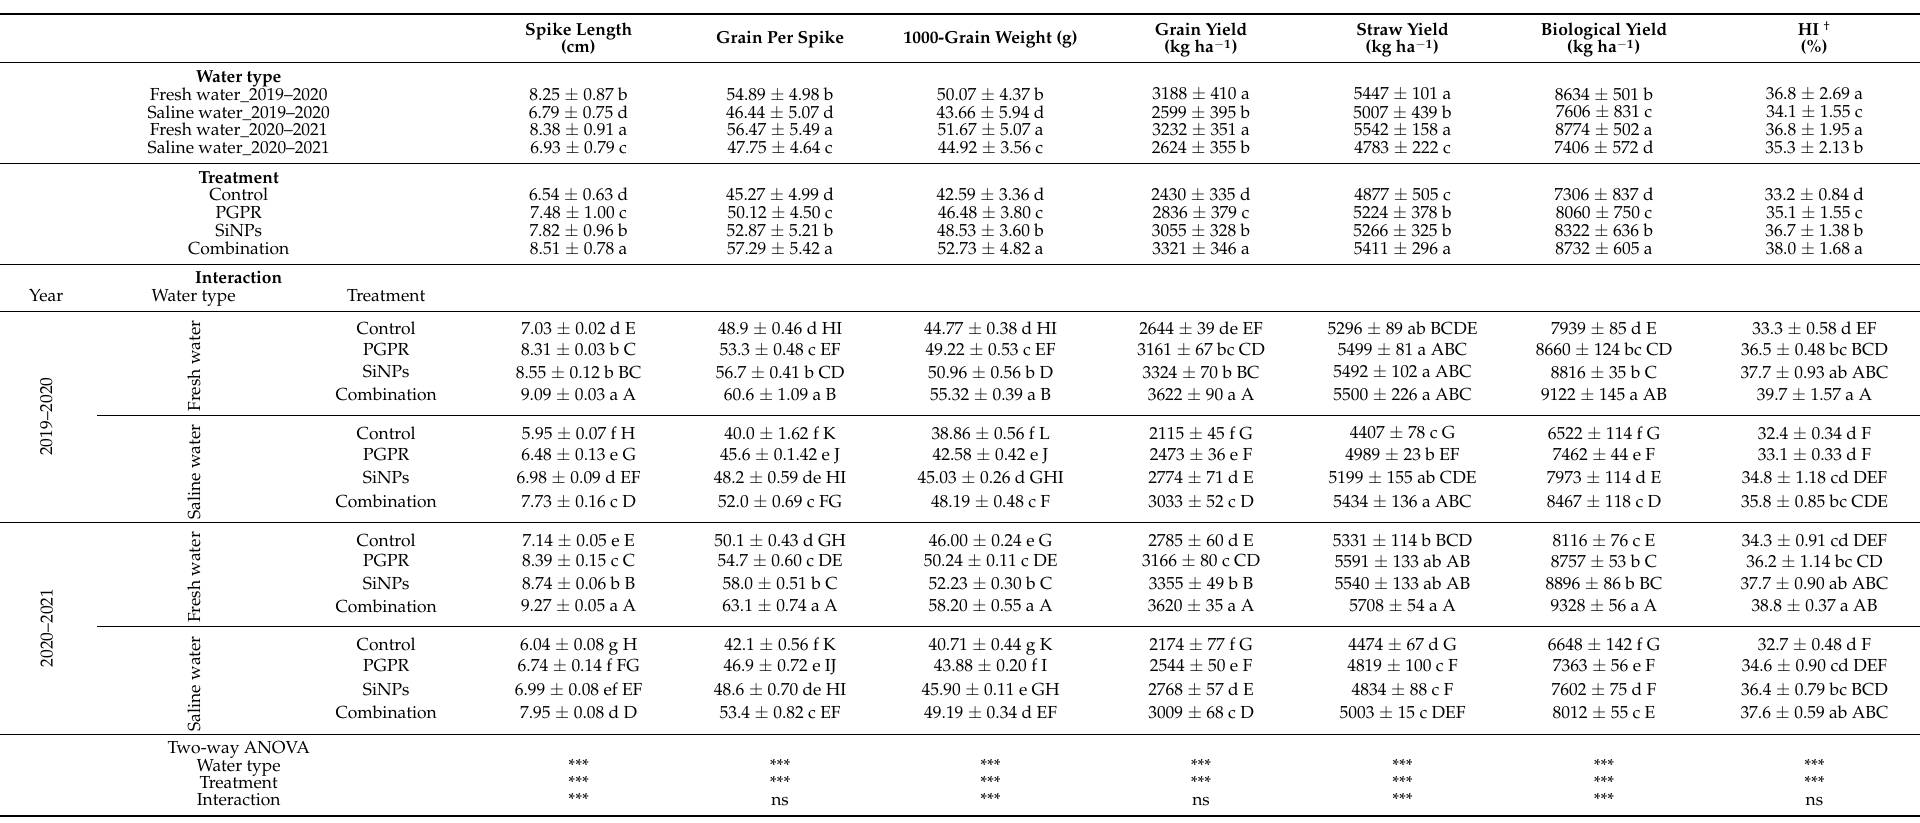
Table 4. Yield and yield-related traits of barley ( Hordum vulgare L., cv. Giza 132), which was cultivated in salt-affected soil and treated with plant growth-promoting rhizobacteria (PGPR; Azotobacter chroococcum SARS 10 and Pseudomonas koreensis MG209738), silica nanoparticles (SiNPs), and their combination to alleviate the detrimental impacts of saline irrigation water during two consecutive seasons. Spike Length (cm) Grain Per